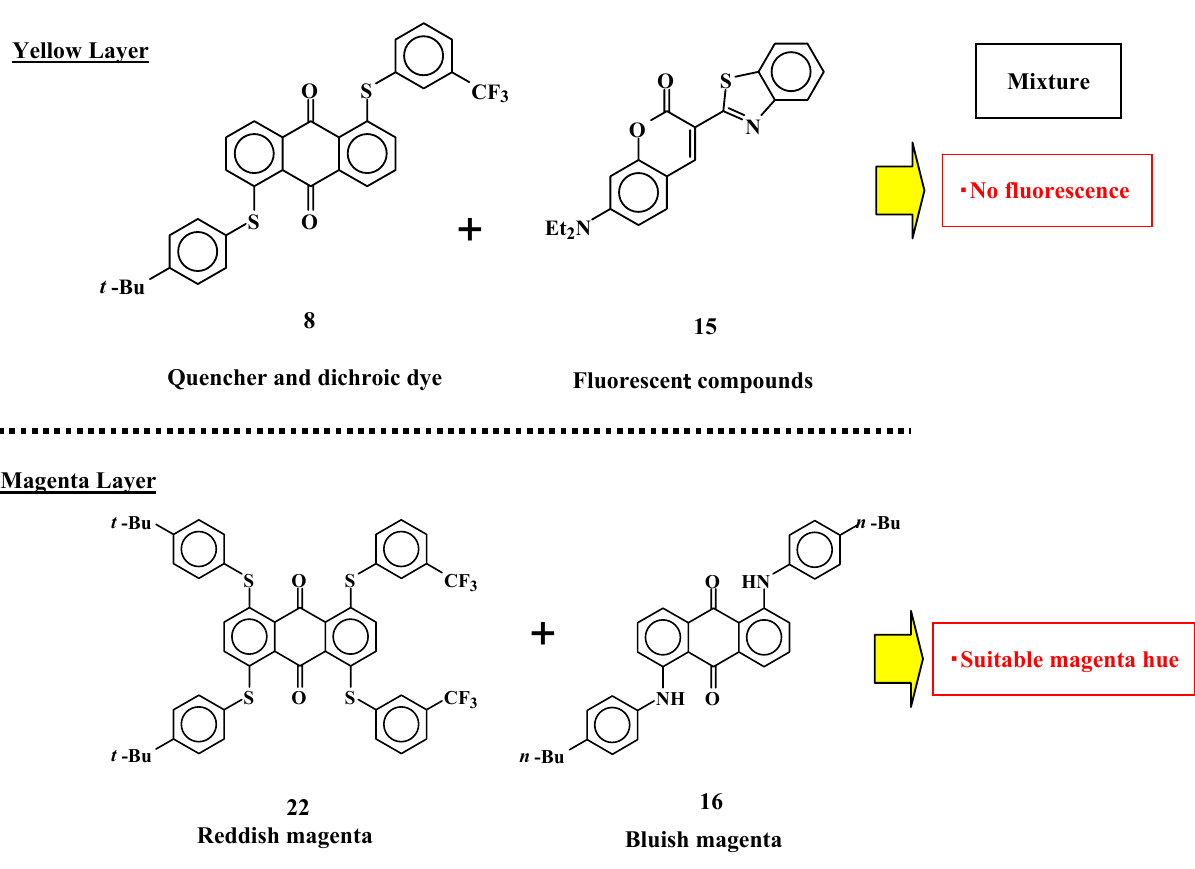
Figure 19. The dyes and/or dye mixtures for the three-layer GH-LCD of yellow and magenta